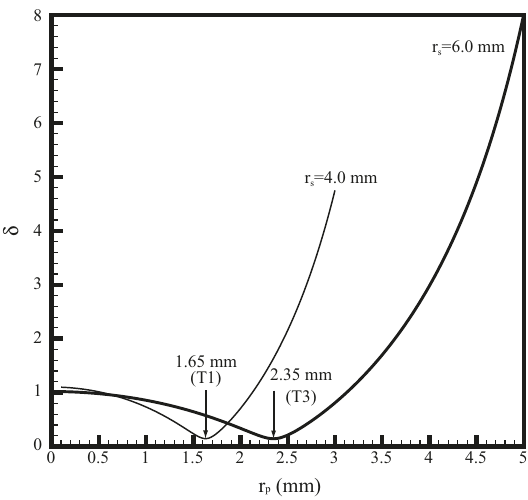
Figure 2. Euclidean norms (cid:2012) as functions of probe radius (cid:1870) (cid:1868) and shoulder radius (cid:1870) (cid:1871) .